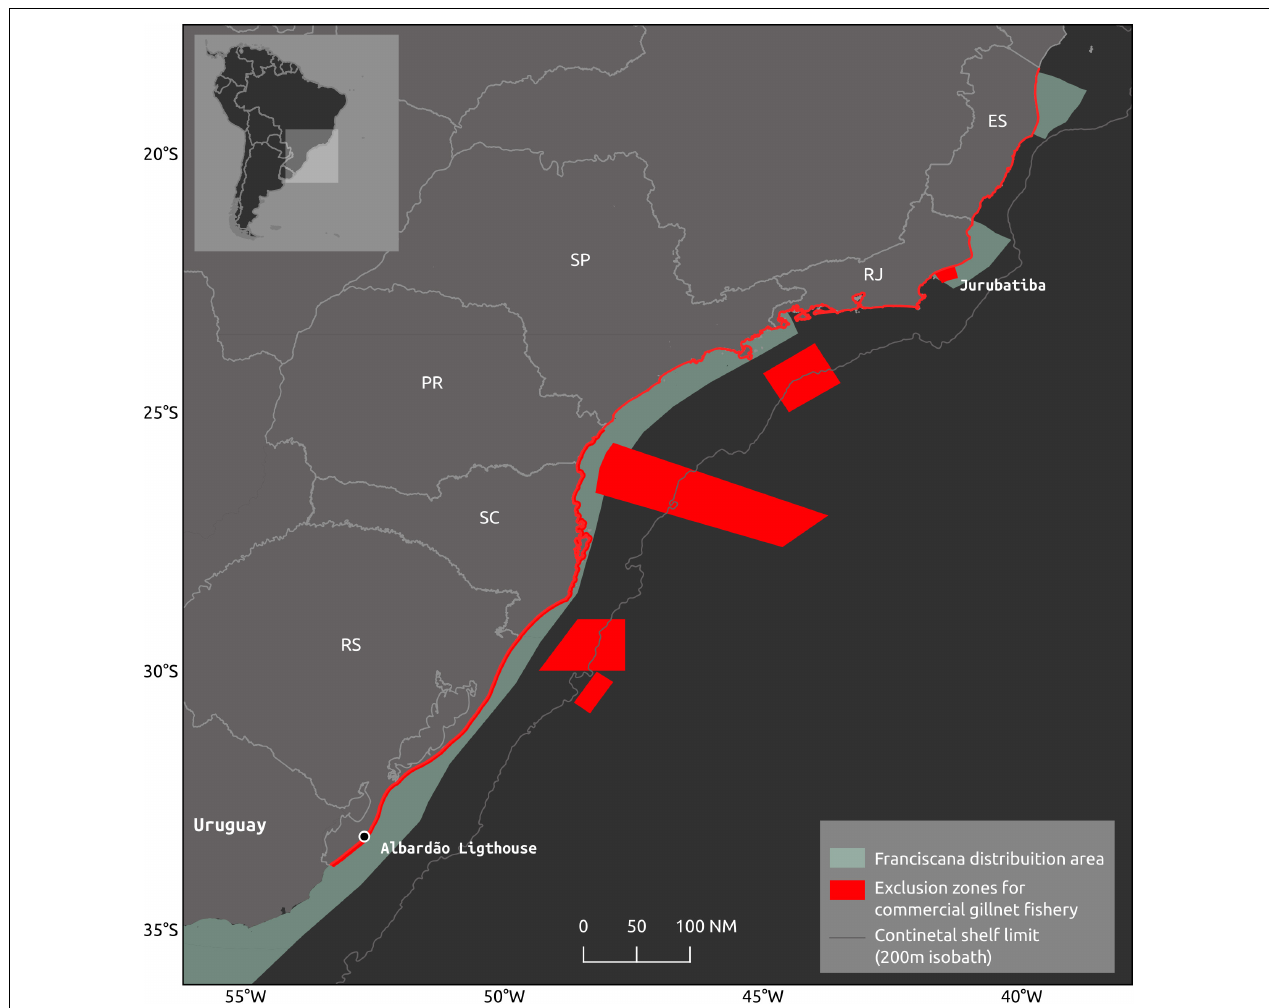
FIGURE 3 | Exclusion areas for commercial gillnet fishery in southern and southeastern States of Brazil: Rio Grande do Sul – RS, Santa Catarina – RS, Paraná – PR, São Paulo – SP, Rio de Janeiro – RJ, and Espírito Santo – ES.